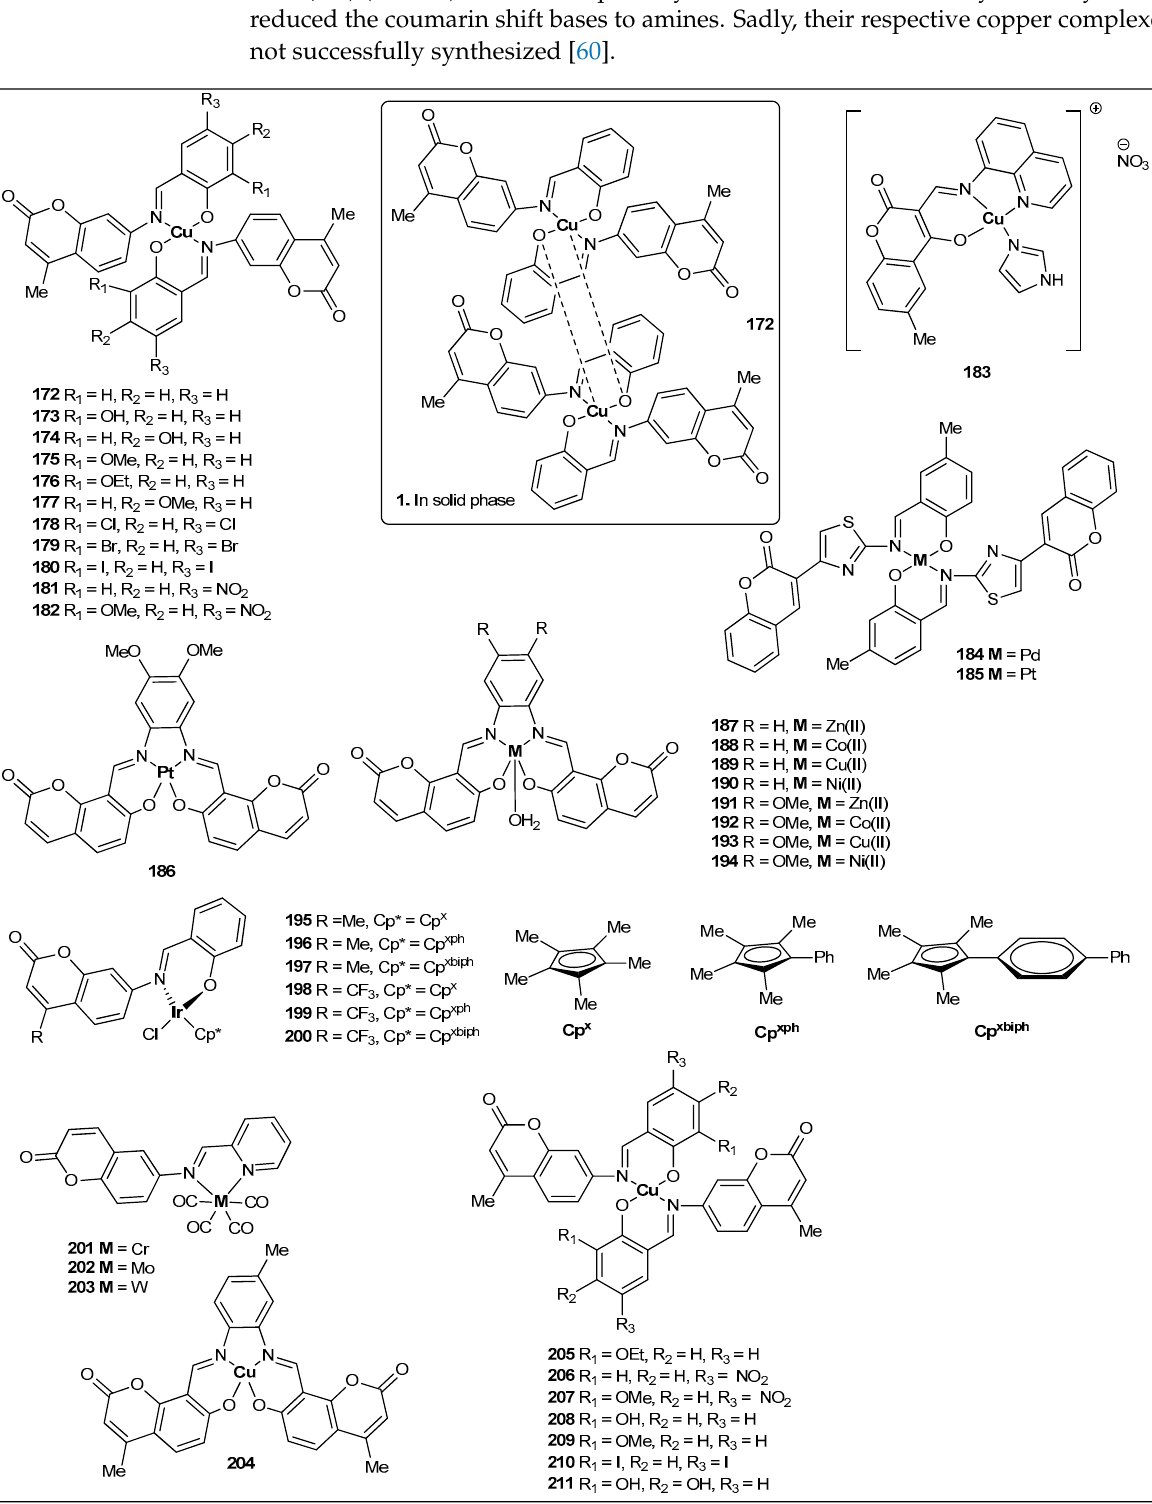
Figure 7. Structures of coumarin-derived imine–metal complexes ( 172 – 217 ).